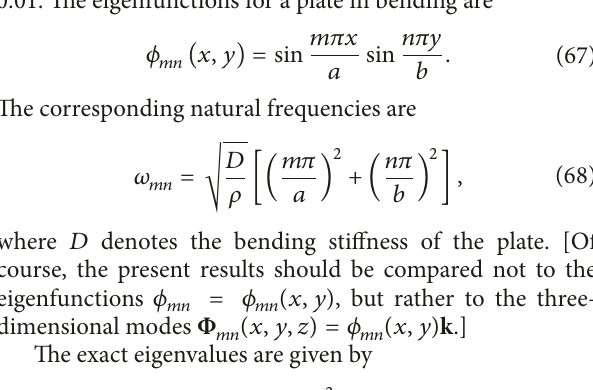
Figure 21: Free beam: three components of the displacement along with the three rotations.]